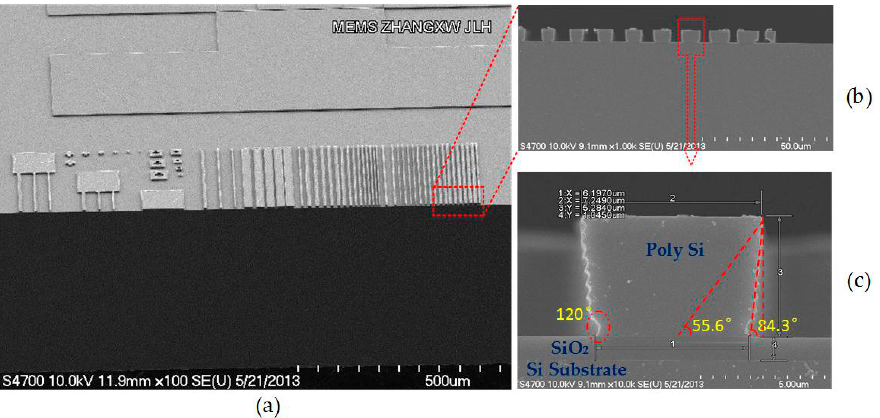
Figure 1. Scanning electron microscope (SEM) cross section for deep reactive ion etching (DRIE) beams: ( a ) top view of beam array; ( b ) side-view of the beams labeled in ( a ); ( c ) side-view of the single beam labeled in ( b ), where the footing effect reflects as an arc angle approximating 120°, the inclination angle of 84.3° and 55.6° in the worst-case.